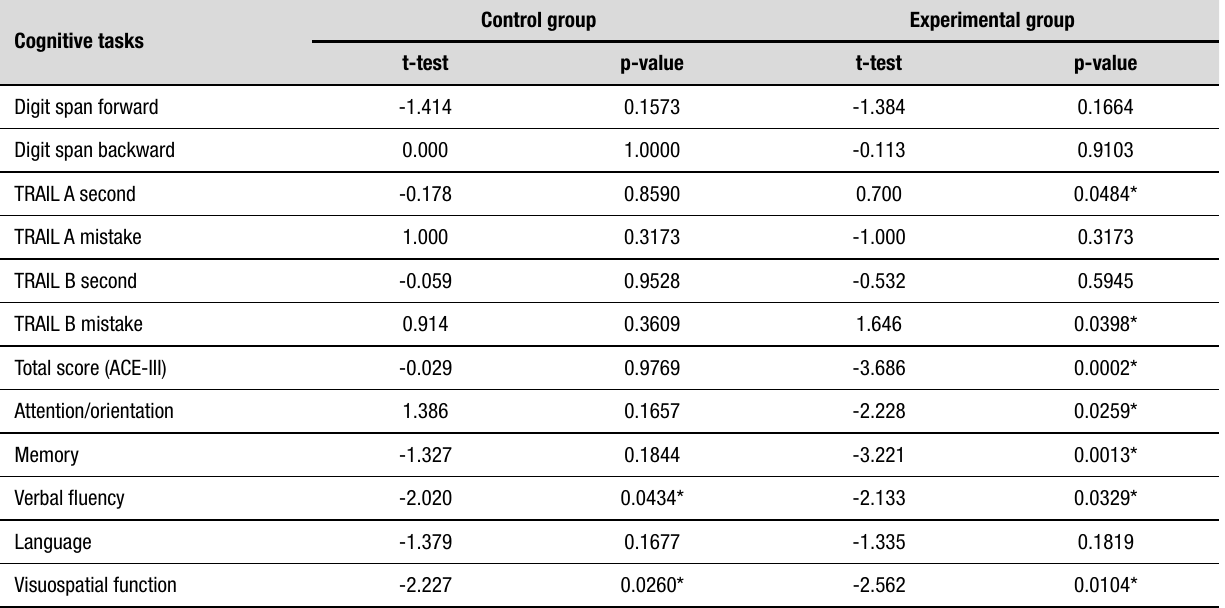
Table 4. Inferential analysis — baseline x post-Intervention evaluations. Cognitive